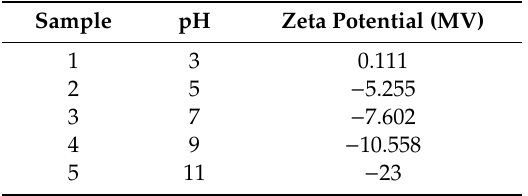
Table 3. Zeta potential results of hybrid CNTs with di ff erent pH values.